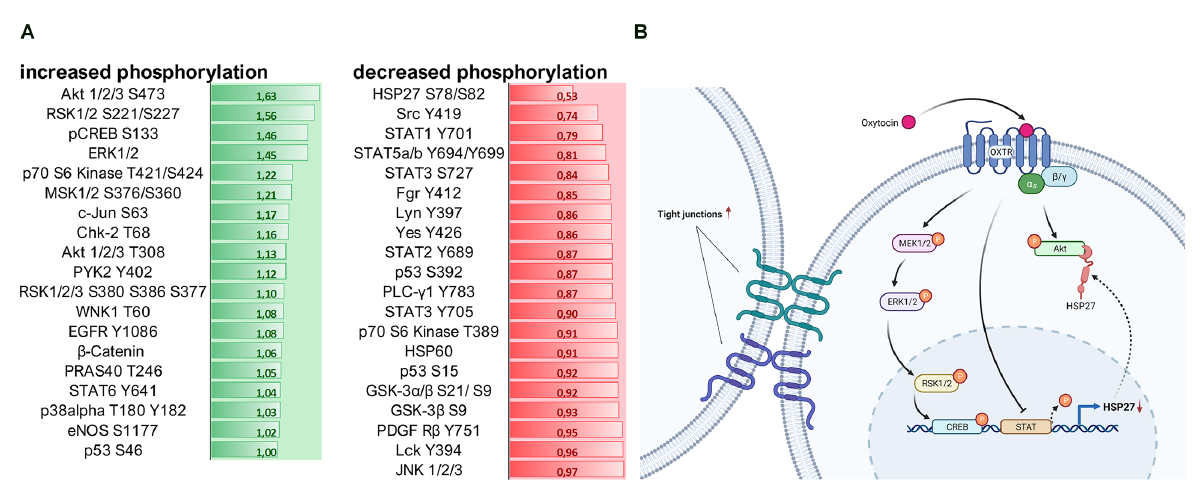
FIGURE5 (A) Assessment of 100 nM OXT-induced signaling cascade activation by quantification of kinase phosphorylation. Data is shown in fold change (green = increase; red = decrease) compared to basal VEH-treated cells. A fold change of greater than ± 0.2 is considered relevant. Signaling cascades involved in cell survival are upregulated, and cascades involved in cell-cell adhesion and cell-matrix interaction are downregulated. (B) Schematic overview of the intracellular signaling cascades activated by the OXTR and their effect on tight junction formation. Created with